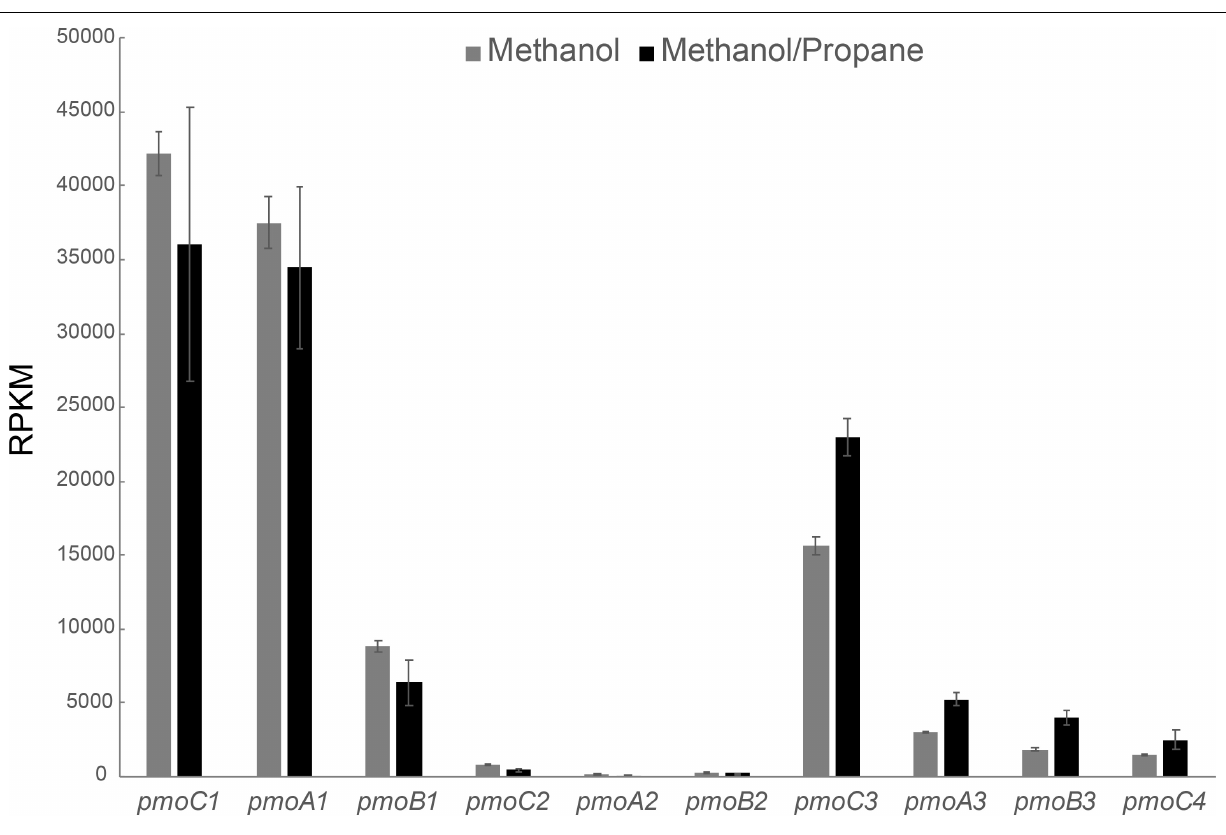
FIGURE 4 | Transcriptome analysis of pMMO encoding operons in M. fumariolicum SolV grown on methanol (gray bars) and methanol plus propane (black bars). Expression values are reported as RPKM. Data is shown as the average over three samples and error bars represent the standard